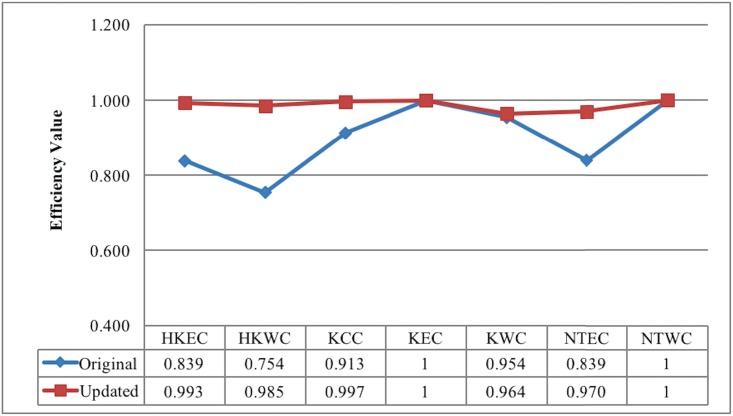
Original vs. Updated: Resource operation efficiencies of each cluster, 2013.